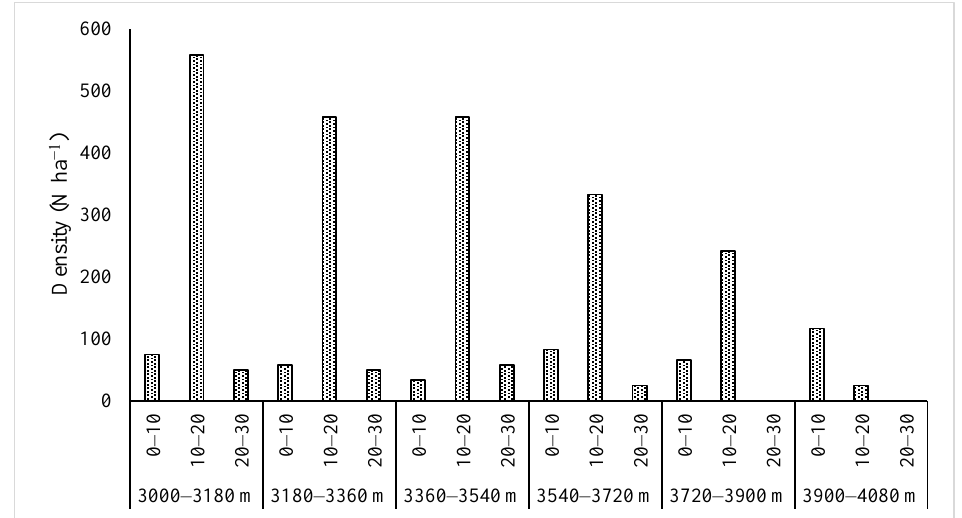
Figure 3. Distribution of J. macropoda in cold desert of Lahaul Valley along elevation and size classes.